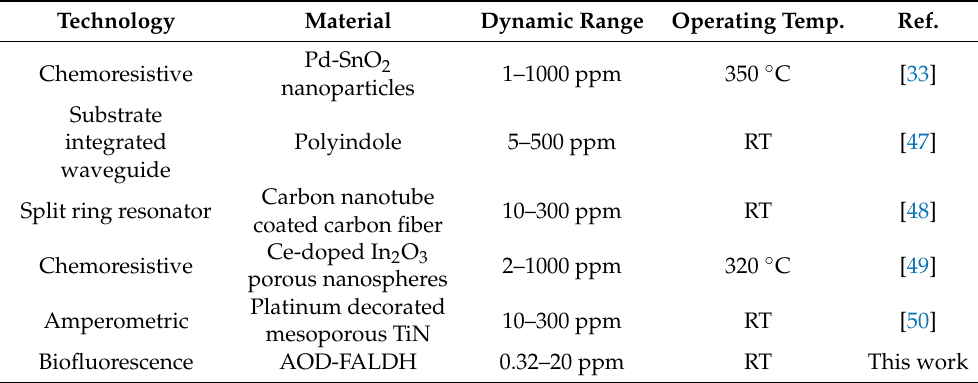
Table 1. Comparison of the proposed MeOH bio-sniffer with various reported sensors.